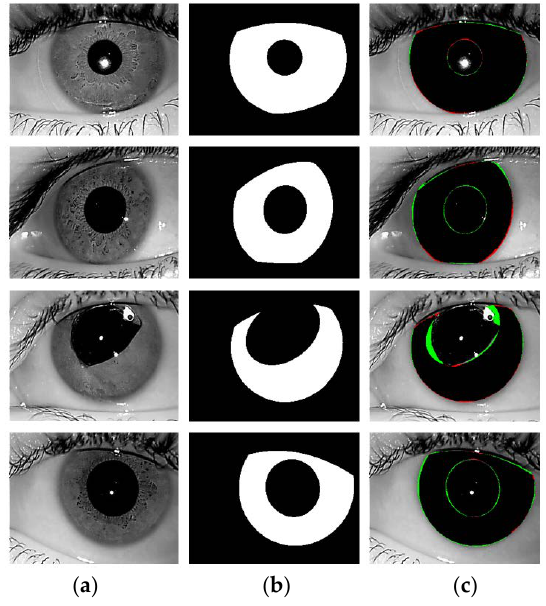
Figure 17. Examples of correct segmentation results in IITD database by the proposed method. ( a ) Original image. ( b ) Ground-truth image. ( c ) Segmentation result by IrisDenseNet (The false positive and negative errors are presented as green and red, respectively. The true positive case is presented as black).